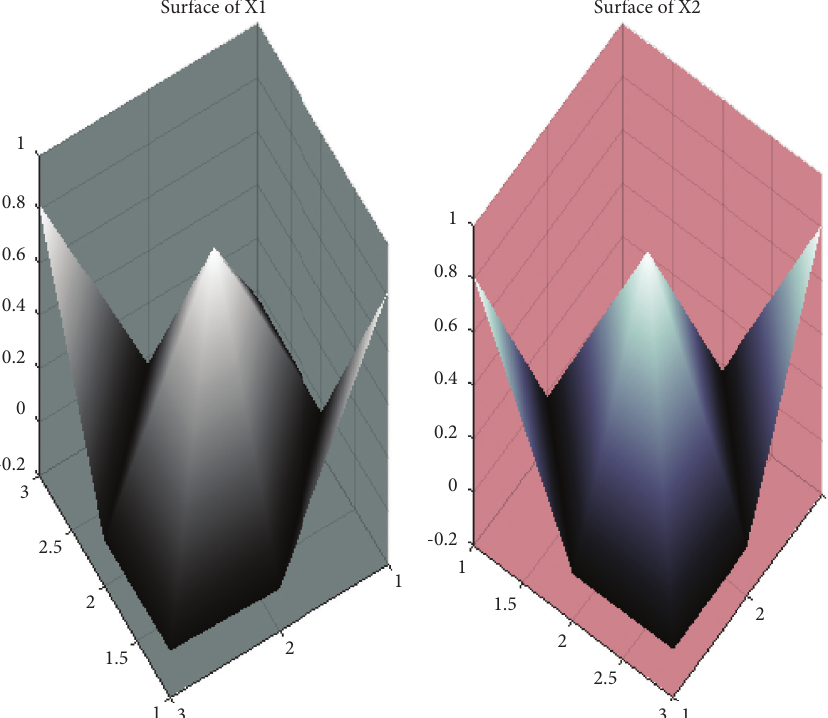
Figure 7: Solution surface plot for dimension